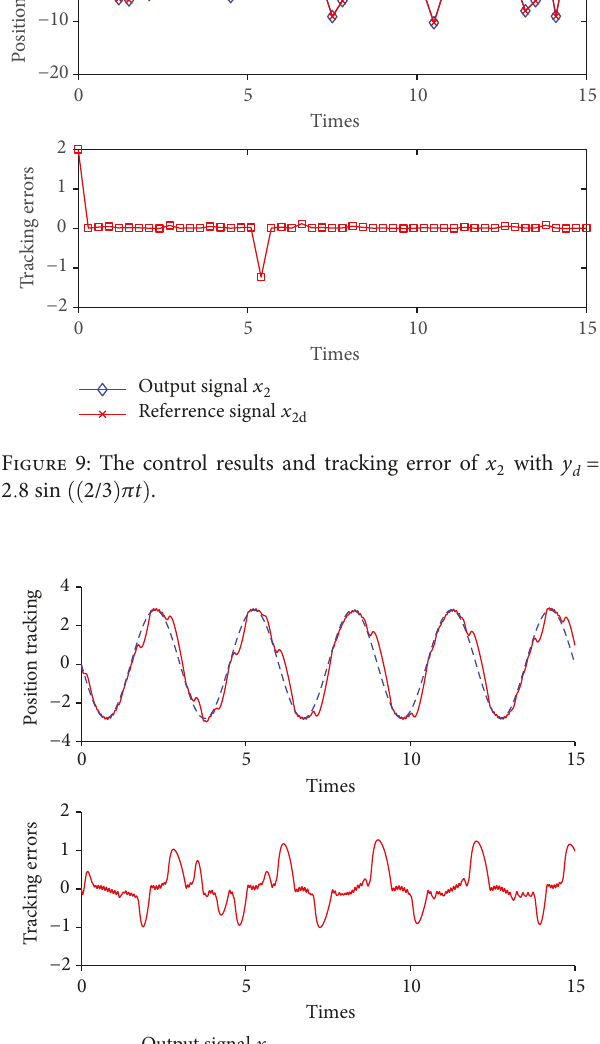
Figure 8: The control results and tracking error of x 2 8 sin 2/3 π t .